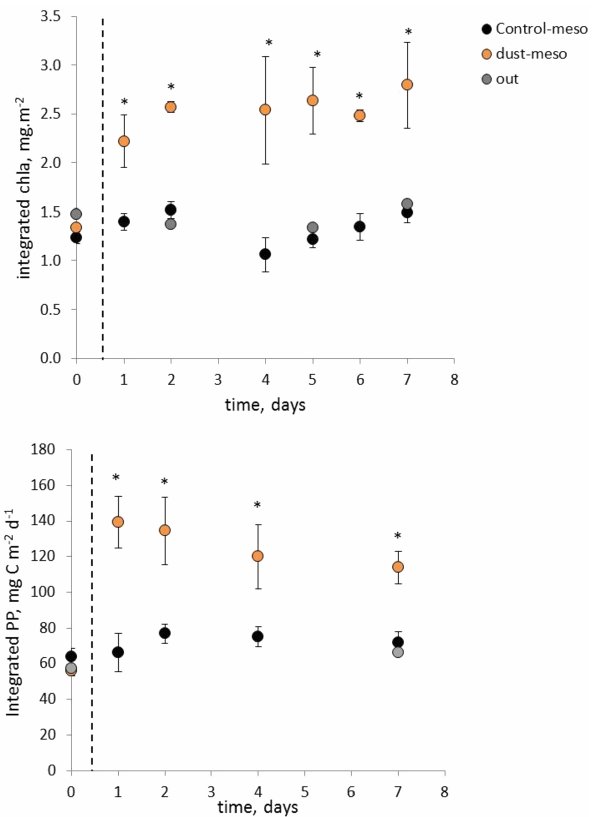
Figure 2. Mean integrated chlorophyll a (Chl a) in mgm − 2 (top panel) and mean integrated primary production (PP) in mg Cm − 2 d − 1 (bottom panel) over mesocosms during the DUNE-1- P experiment in the Control-meso (black dot), Dust-meso (orange dot) and out (grey dot). The dotted line represents the time of the dust seeding. Data in the Control-meso and Dust-meso represent the average and standard deviations of the three replicate mesocosms.